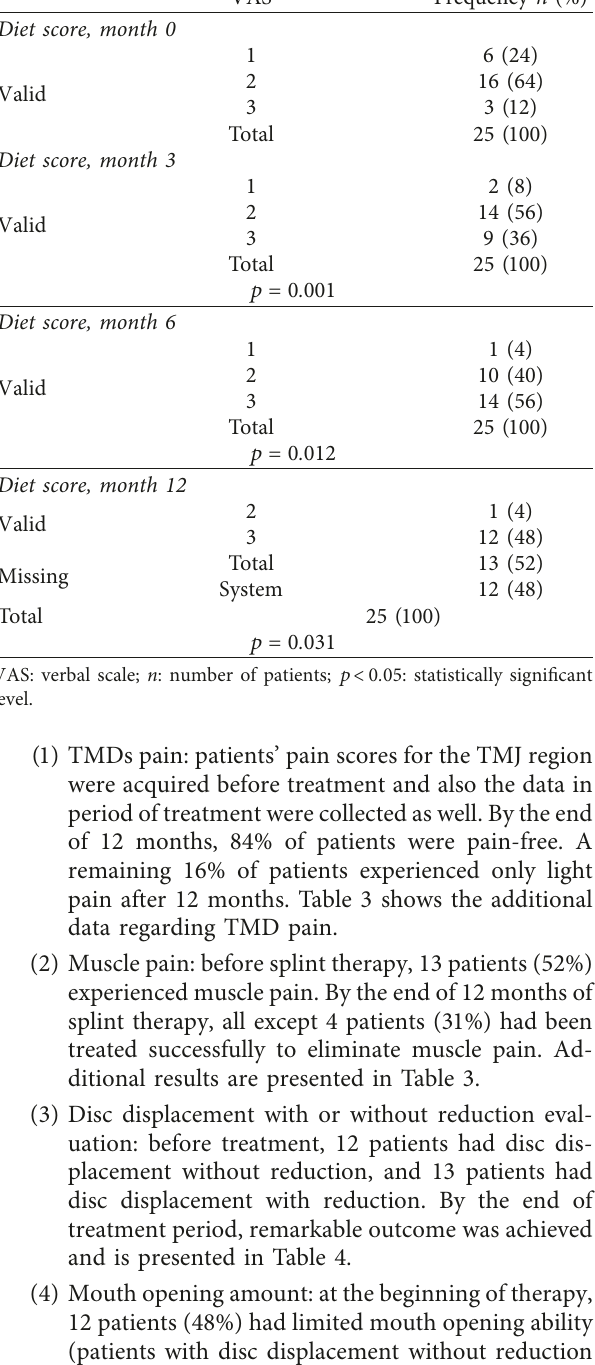
Table 2: Statistic calculation of the patient’s variables including “distribution of patients’ splint usage duration in a day with respect to total healing” during treatment